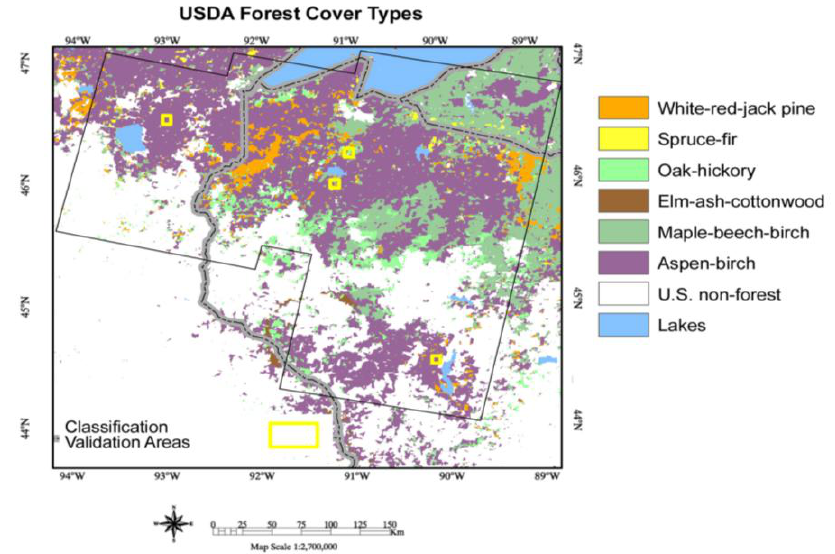
Figure 4. The geographic extent of forest cover types throughout the study region. The black open polygon indicates the Landsat image bounds, and yellow quadrangles indicate the locations of high-resolution validation